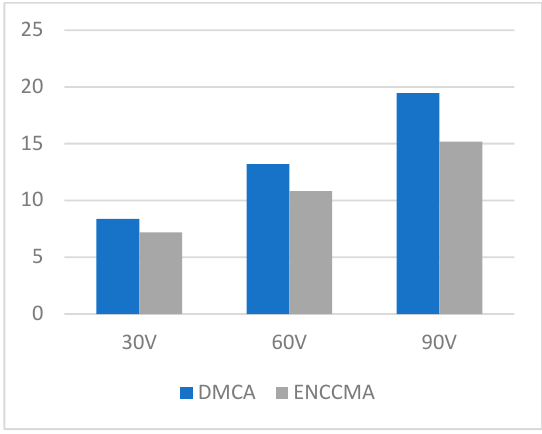
Figure 4. Throughput for the highway environment.